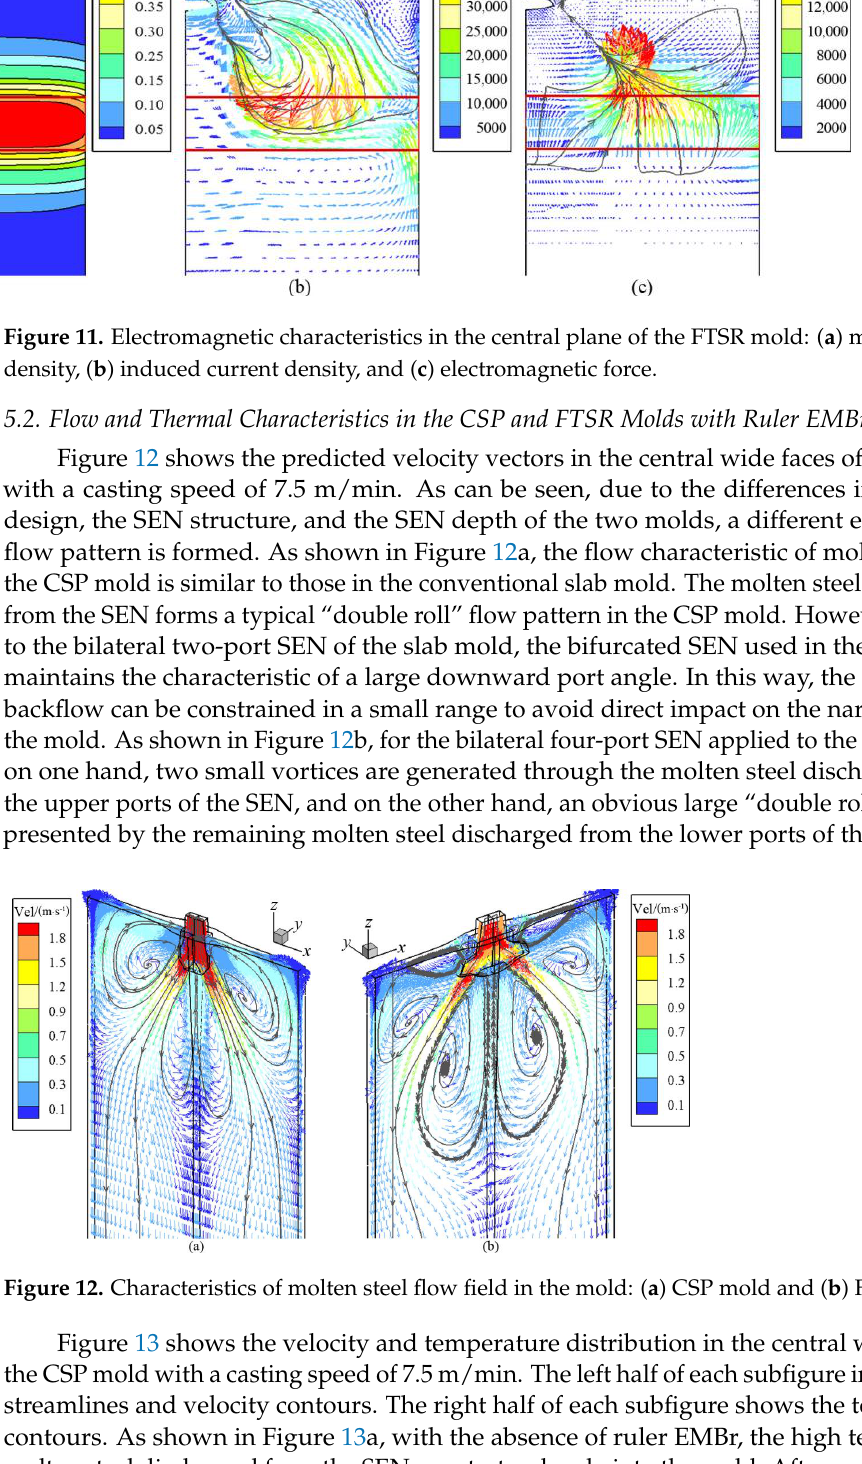
Figure 12. Characteristics of molten steel flow field in the mold: ( a ) CSP mold and ( b ) FTSR mold.